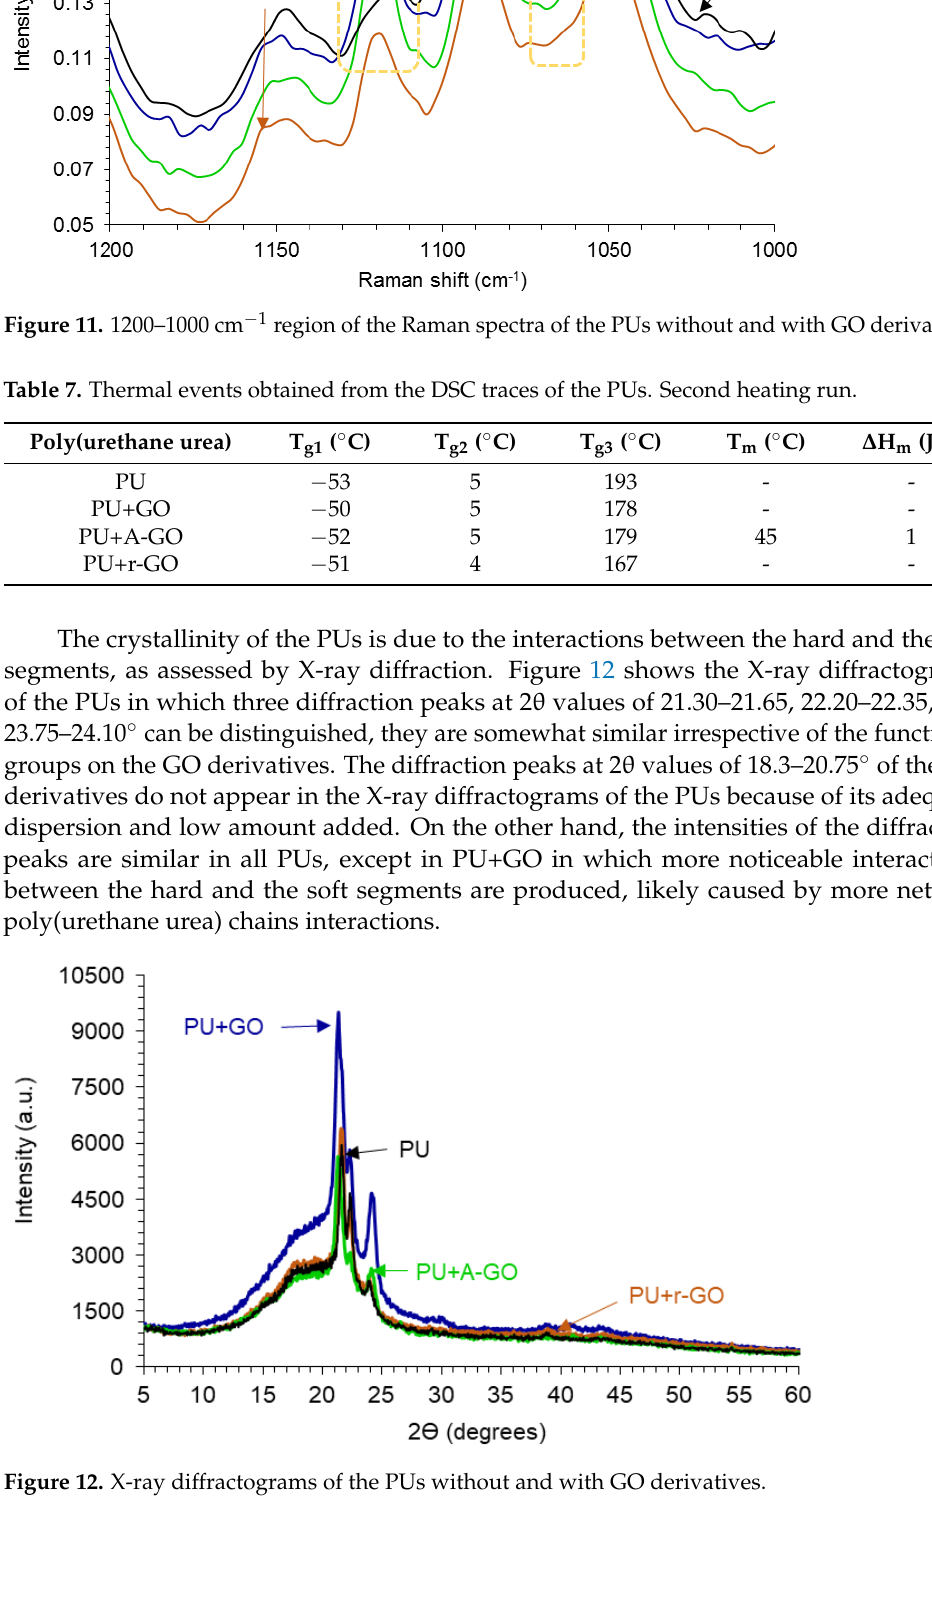
Figure 12. X-ray diffractograms of the PUs without and with GO derivatives. The thermal stability and structure of the PUs were assessed by TGA. Figure 13a shows the variation of the weight as a function of the temperature of the PUs. PU+GO shows lower thermal stability than PU and the other PU+GO derivatives, likely due to more noticeable structural changes. The thermal stabilities of the PUs were quantified by the temperatures at which 5 (T 5% ) and 50 (T 50% ) wt.% are lost. According to Table 8, the addition of all GO derivatives decreases the value of T 5% , due to the interactions between the hard and soft domains caused by the intercalation of the graphene nano-sheets. The lowest value of T 5% corresponds to PU+A-GO, as the soft segment content is higher than in the rest. On the other hand, the value of T 50% is similar in all PUs, except in PU+GO which is lower. Some literature has established the improved thermal stability of the pol- yurethane composites containing graphene derivatives [17,34,35], but the opposite trend is found in this study, this can be due to the small amount added of the GO derivatives and to the dominant effect of the GO derivative morphology of the nano-sheets in chang- ing the structure of the hard and soft domains. Thus, the thermal stability of the PU is differently affected by adding GO derivatives with different functional groups.